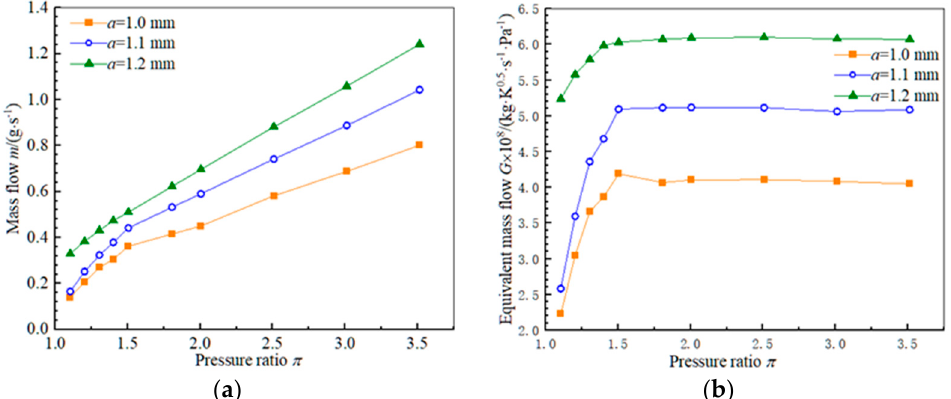
Figure 8. Experimental results of different edge plate clearances ( c = 1 mm). ( a ) Total leakage against the pressure ratio. ( b ) Equivalent mass flow of total leakage against pressure ratio. Table 2. The range of total leakage and the critical equivalent mass flow of total leakage.